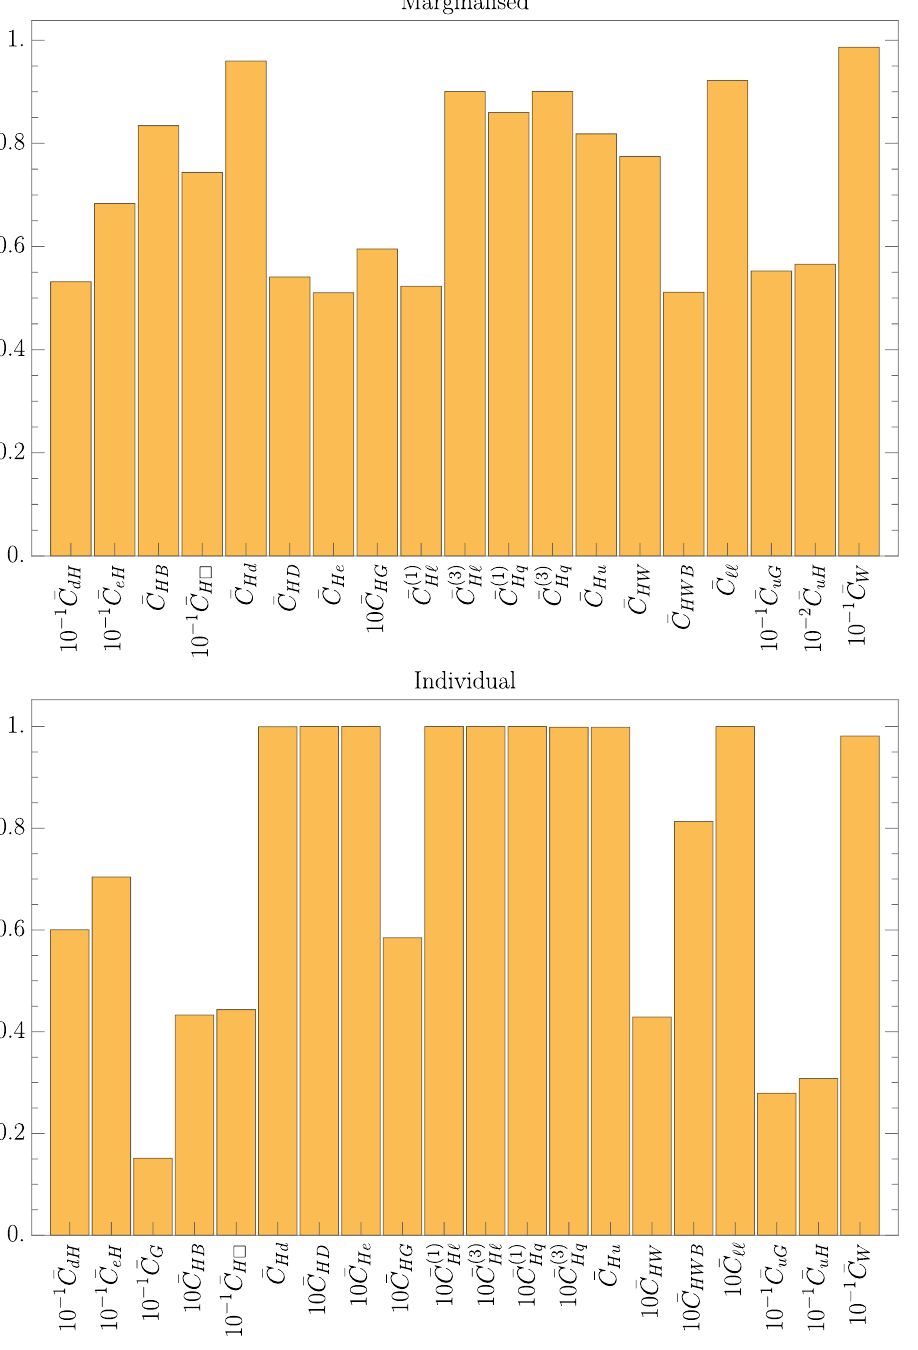
Figure 4. The relative improvement in the standard deviations of the Wilson coe(cid:14)cients in the Warsaw basis when LHC Run 2 data are added to the (cid:12)ts (a lower number correspond to more improvement). The upper and lower panels correspond to when all operators are included simultaneously or when switching on each operator individually, respectively.